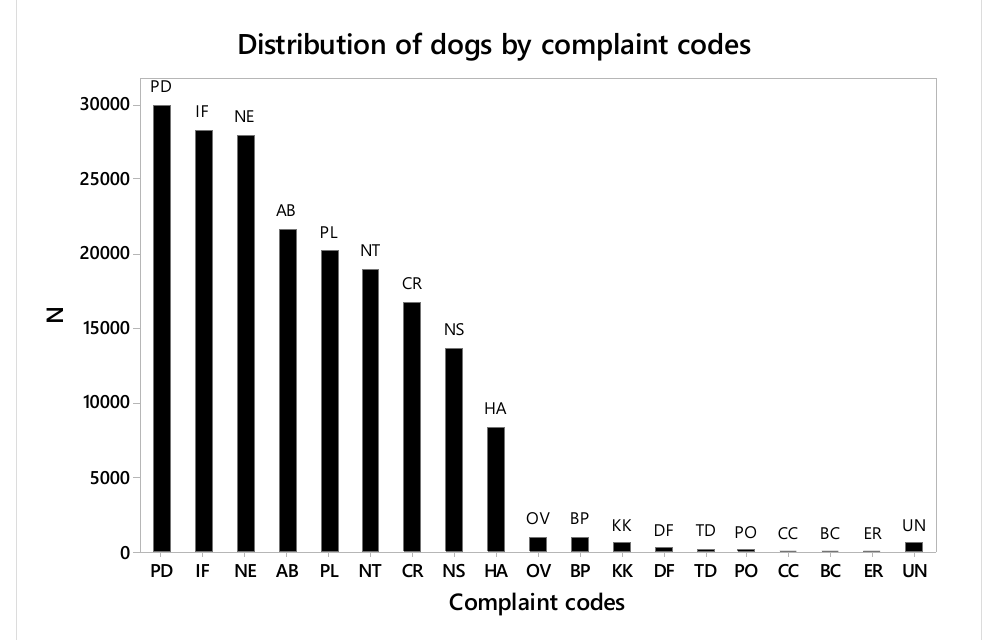
Figure 1. Distribution of dogs by complaint code. PD-Poor dog condition (27.9%, N = 29,982); IF-Insufficient food and/or water (26.3%, N = 28,265); NE-No exercise/confined/tethered (25.9%, N = 27,913); AB-Abandonment (20.1%, N = 21,626); PL-Poor living condition (18.7%, N = 20,162); NT-No treatment (17.6%, N = 18,963); CR-Cruelty (15.5%, N = 16,661); NS-No shelter (12.7%, N = 13,682); HA-